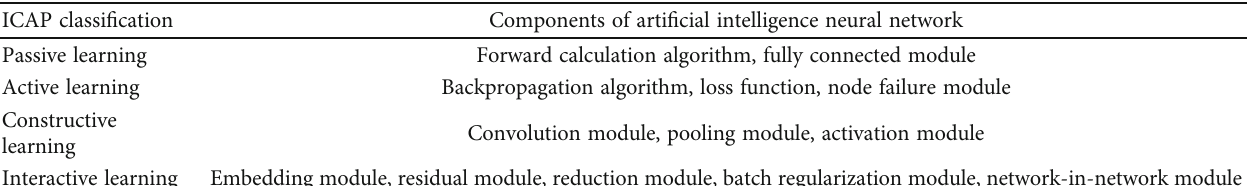
Figure 5: For learning styles and their evolution. Table 1: Correspondence between four learning methods and adaptive neural network